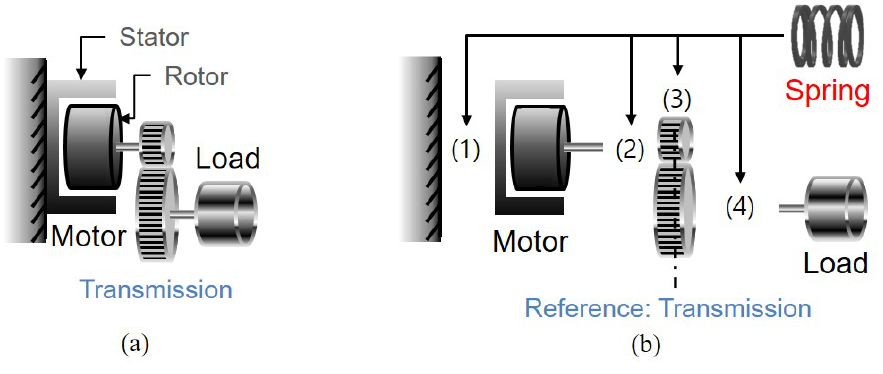
Figure 3. ( a ) Rigid Actuator; ( b ) Series Elastic